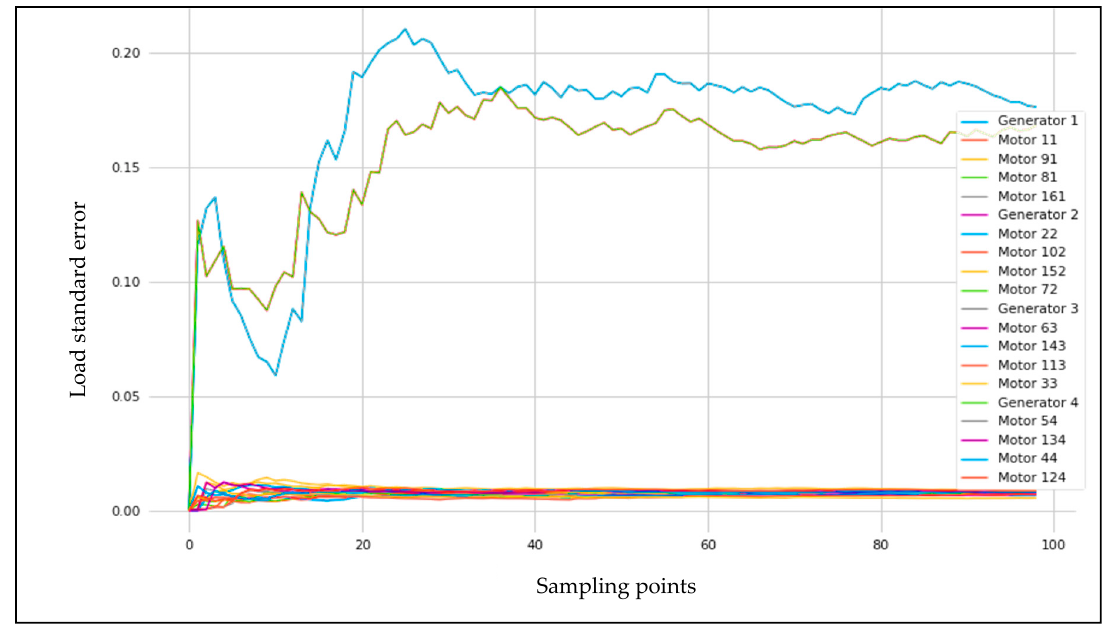
Figure 21. Latin hypercube standard deviation for the RTO case study.